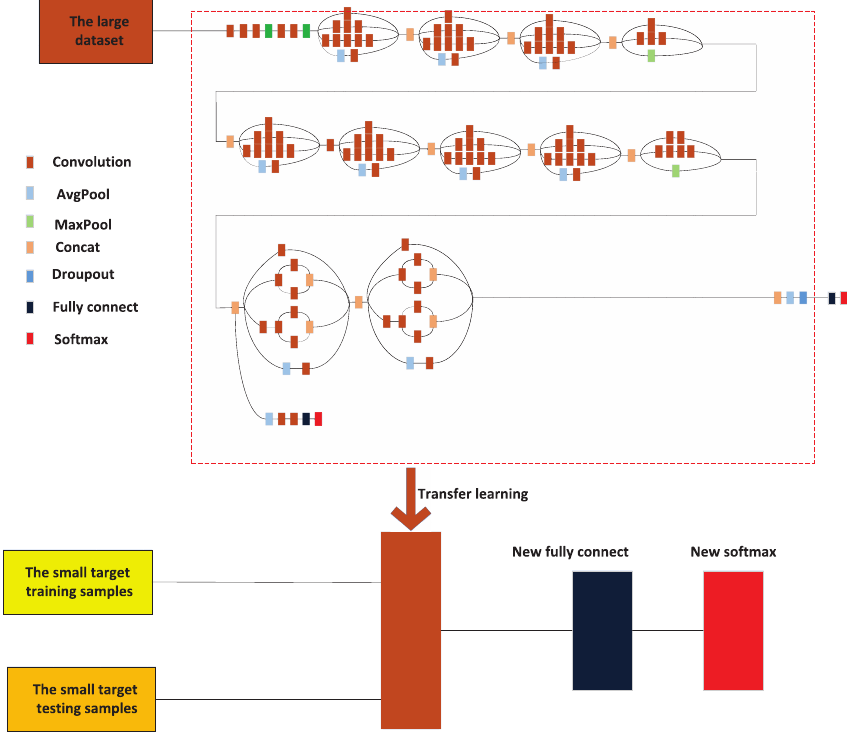
Figure 9. The flowchart of transfer learning method. The parameters in the red dotted line were trained in the large sample, and these parameters can be directly transferred to the new small training samples for fine-tuning, and the new fully connect layer and the new softmax layer are retrained by the new target training